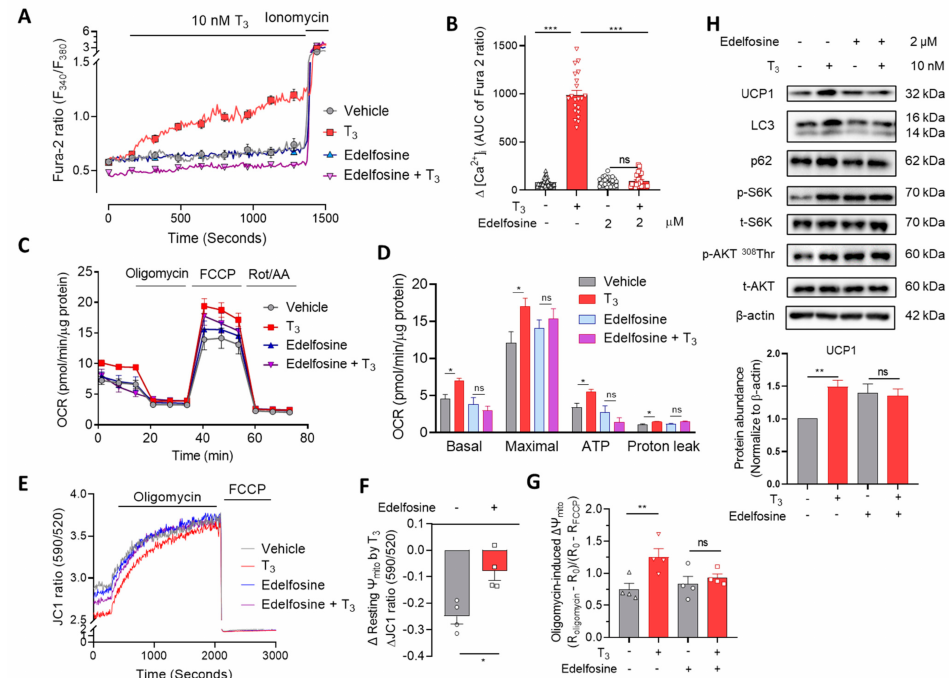
Figure 4. PLC inhibitor prevents T 3 -induced [Ca 2+ ] i increase and mitochondrial activation. ( A ) Cy- tosolic Ca 2+ measurement by Fura-2 AM with or without 2 µ M edelfosine treatment for 6 h before 10 nM T 3 perfusion on immortalized brown adipocytes. ( B ) Quantitative analysis of cytosolic Ca 2+ in vehicle- or T 3 -treated group with and without edelfosine treatment. ( C ) OCR measurement in primary brown adipocytes with 2 µ M edelfosine treatment for 6 h before 10 nM T 3 treatment for 30 min. ( D ) Quantitative analysis of basal respiration, maximal respiration, ATP production, and proton leak ( n ≥ 5) ( E ) Ψ m measurement using JC1 dye with 10 nM T 3 treatment for 30 min in immortalized brown adipocytes. ( F ) Quantitative analysis of T 3 -induced differences in resting Ψ m with and without edelfosine treatment. ( G ) Quantitative analysis of oligomycin-induced hyperpolar- ization. ( H ) Western blot of UCP1, autophagy-related proteins, and mTOR signaling proteins with 2 µ M edelfosine treatment for 6 h before 10 nM T 3 treatment in immortalized brown adipocytes and quantitative analysis of UCP1. Data were presented as mean ± SEM. * p ≤ 0.05, ** p ≤ 0.01, *** p < 0.001, ns not